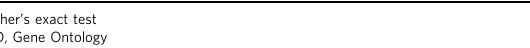
Table 1 Representative GO terms for genes downregulated and upregulated by Actb knockdown GO term P -value Downregulated Multicellular organismal